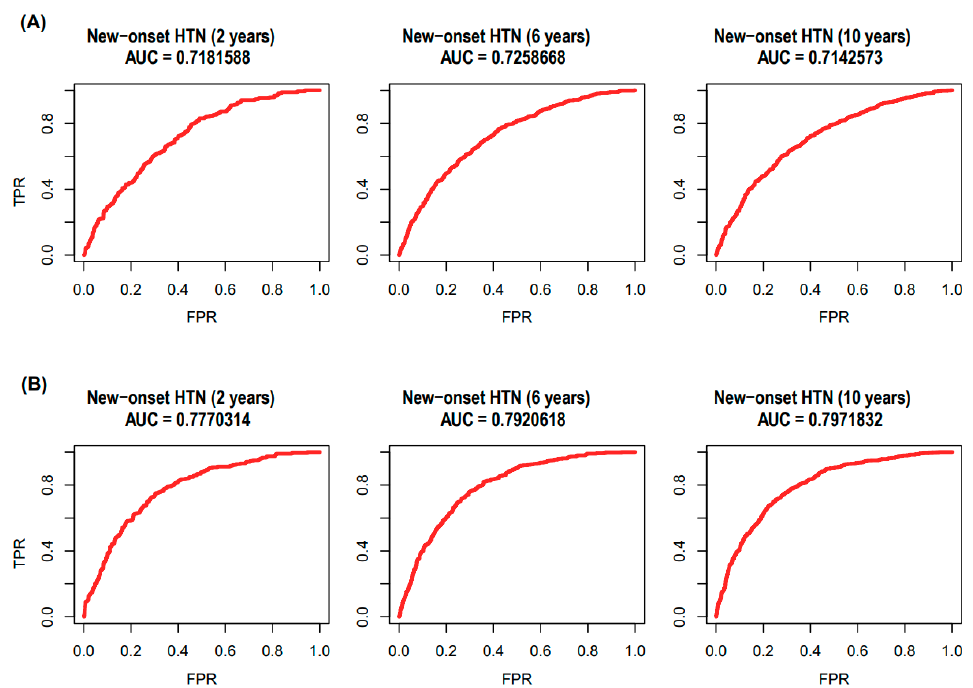
Figure 5. ROC curves for the sex-specific hypertension prediction model using KoGES dataset. ( A ) New-onset HTN during 2-year follow-up (AUC = 0.718), 6-year follow-up (AUC = 0.726), and 10-year follow-up (AUC = 0.714) in Men. ( B ) New-onset HTN during 2-year follow-up (AUC = 0.777), 6-year follow-up (AUC = 0.792), and 10-year follow-up (AUC = 0.797) in women. Abbreviations: ROC, receiver-operating characteristic; KoGES, Korean Genome and Epidemiology Study; AUC, area under the curve; HTN, hypertension; TPR, true positive rate; FPR, false-positive rate.